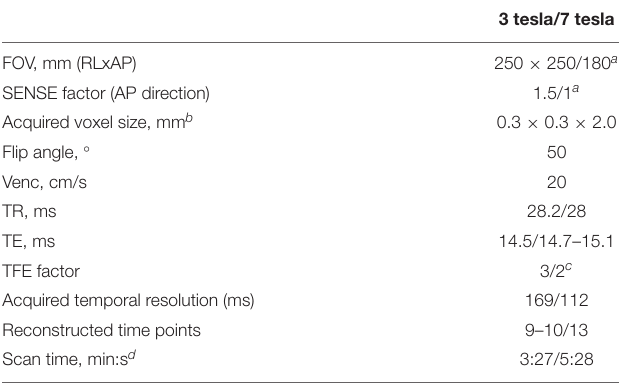
TABLE 1 | Imaging parameters of the 2D phase contrast sequence of 3 tesla and 7 tesla